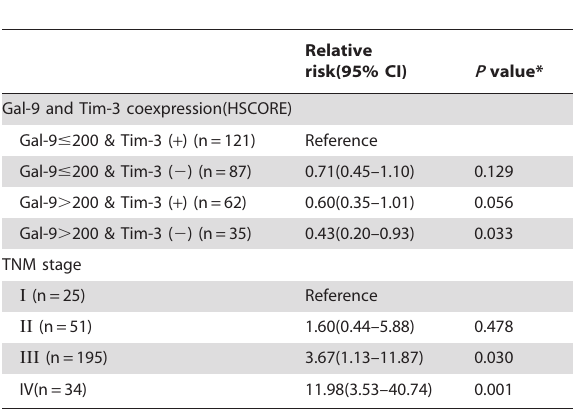
Table 2. Multivariate analysis for prediction of overall survival in gastric